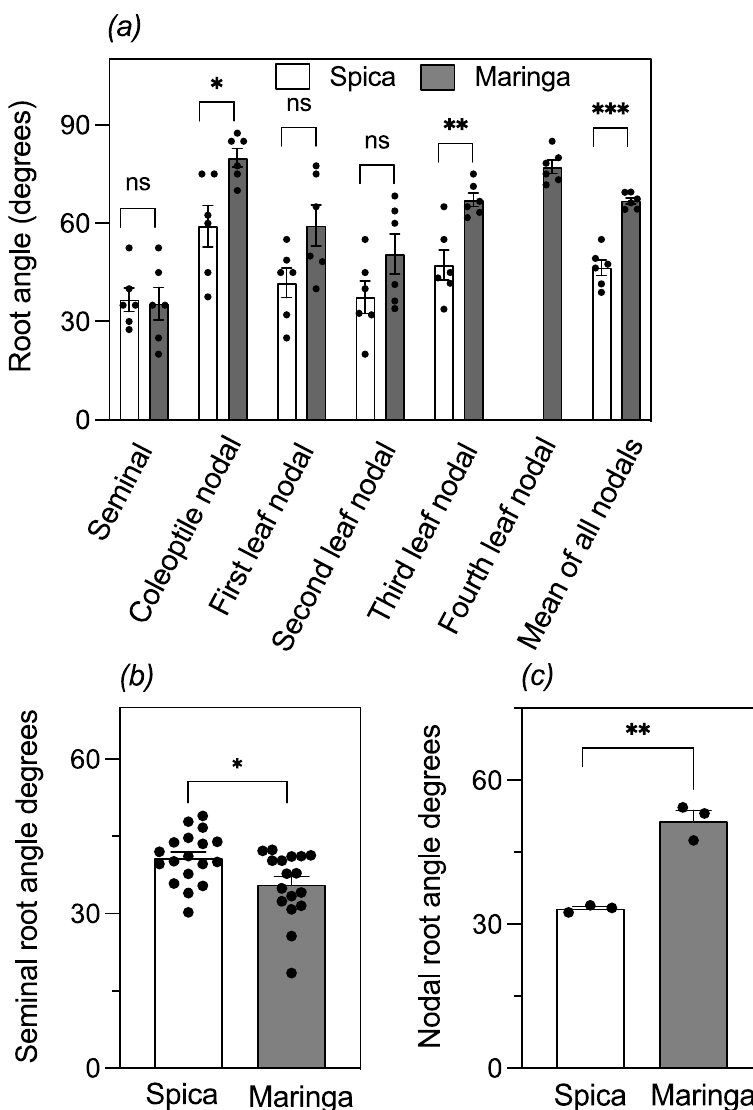
Figure 6. Nodal and seminal root angles of Maringa and Spica. Plants were grown in potting soil for 33 days in tubes after which roots were washed out and root angles for the various classes of roots were measured ( a ; n = 6). Seminal root angles of five-day old seedlings were determined by the clear-pot method as described by Richard et al. [26]. Angles were measured for the first of the seminal roots developing either side of the primary seminal root (n = 18 for Spica and n = 17 for Maringa) ( b ). Nodal root angles after 33 days of growth were determined by measuring the interception of roots against the sides of clear tubes and calculating the angles by simple trigonometry ( c ; n = 3). Individual values are shown as circles with calculated data shown as the mean ± SE, and Maringa was compared to Spica for the various root types using a Student’s t -test (* p < 0.05; ** p < 0.01; *** p < 0.001).